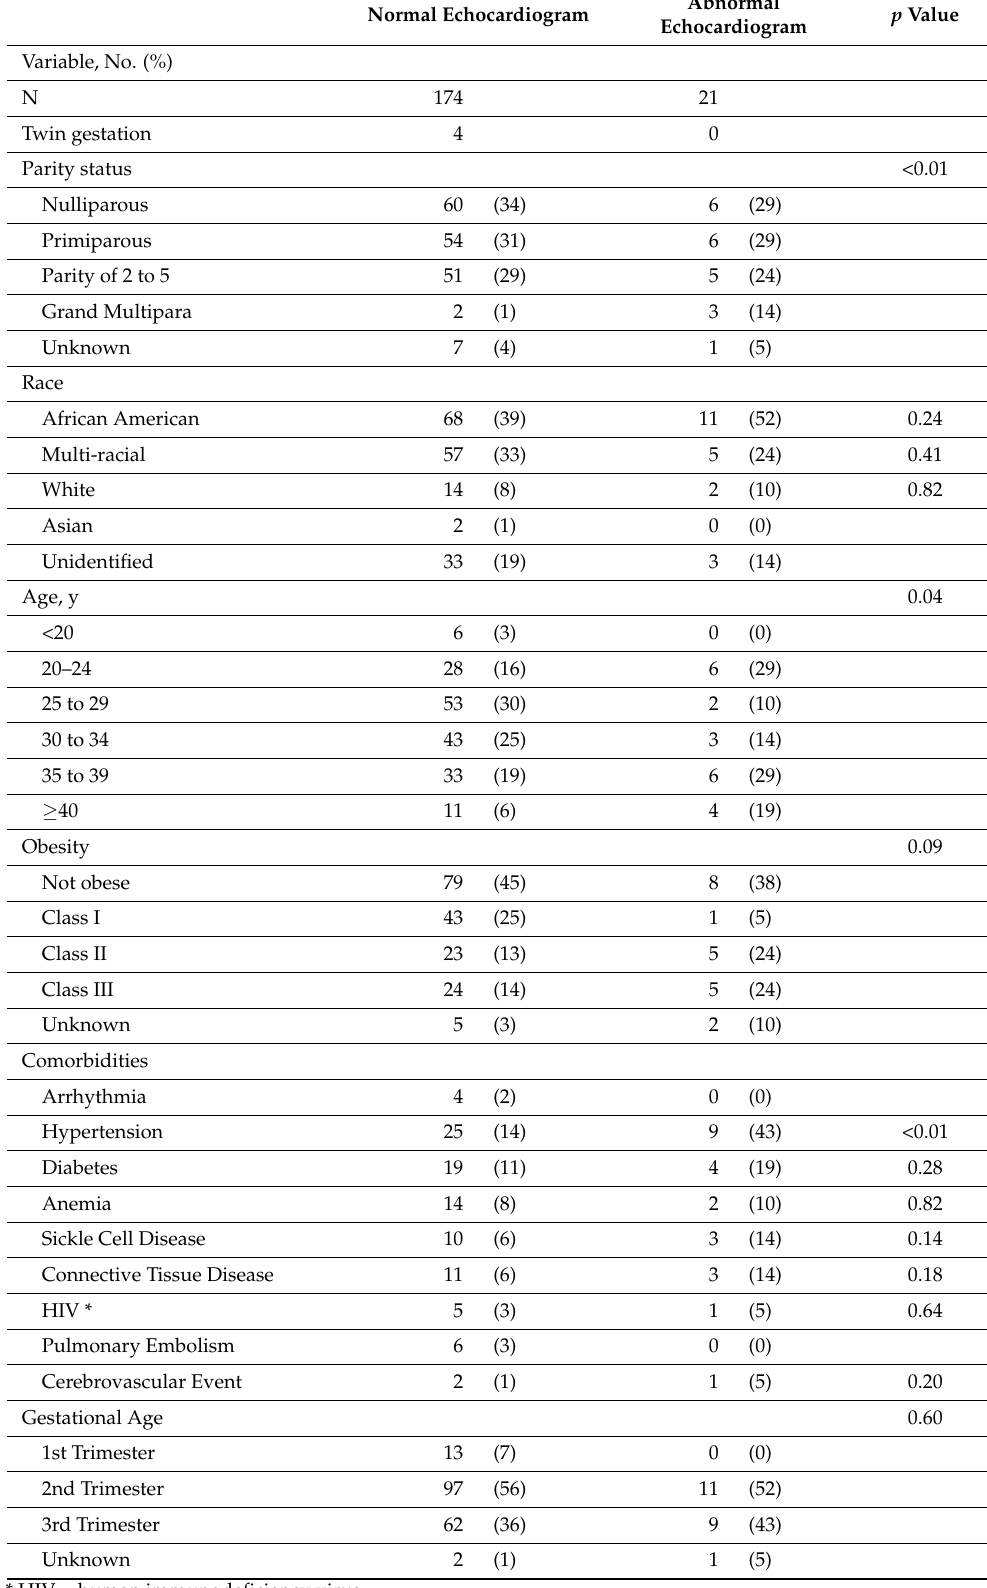
Table 4. Characteristics of low-risk pregnant women with normal and abnormal echocardiograms. Abnormal Normal Echocardiogram